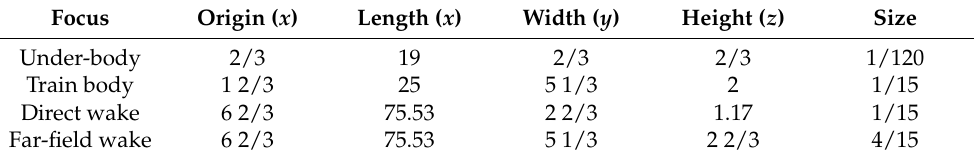
Table A2. Dimensions and element size of the four refinement zones (all distances are standardised by L Ref